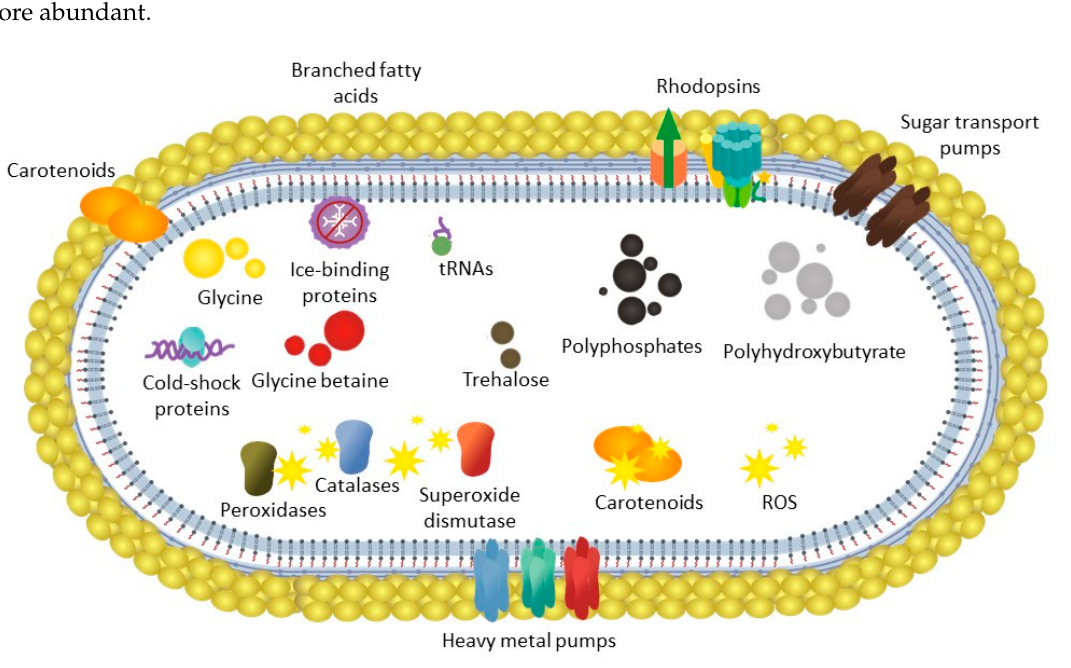
Figure 5. Traits annotated in the S. vilae DB165 T genome considered to be involved in its adaptation to the Llullaillaco Volcano Lake. ROS, reactive oxygen species.